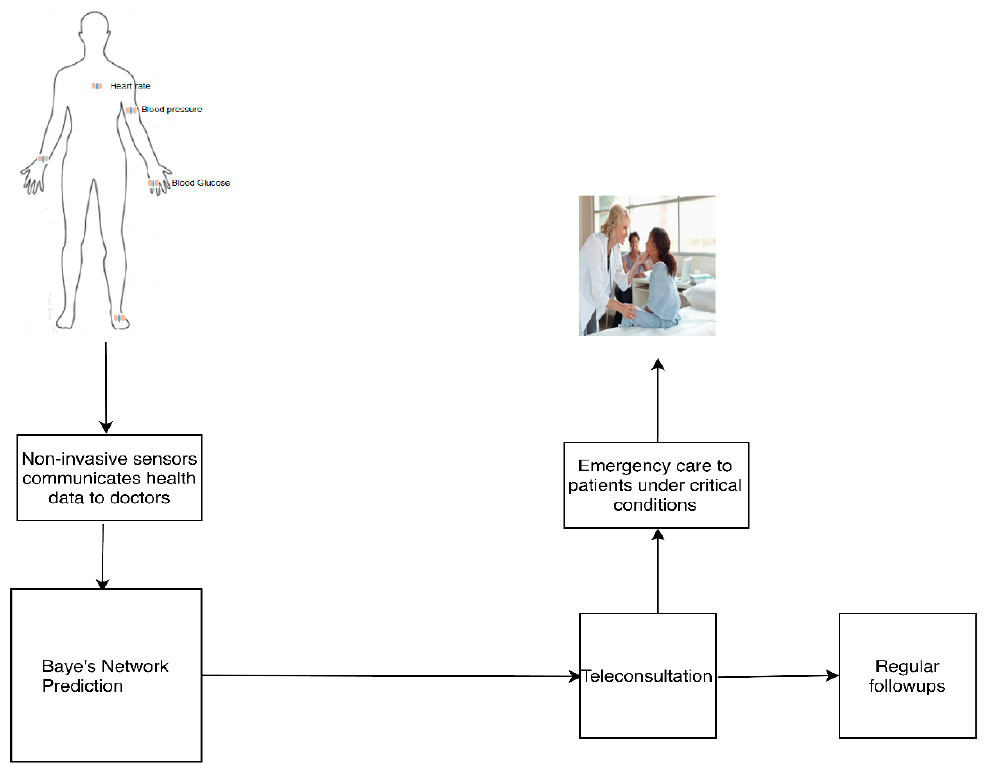
Figure 1. Schematic view of the methodology.